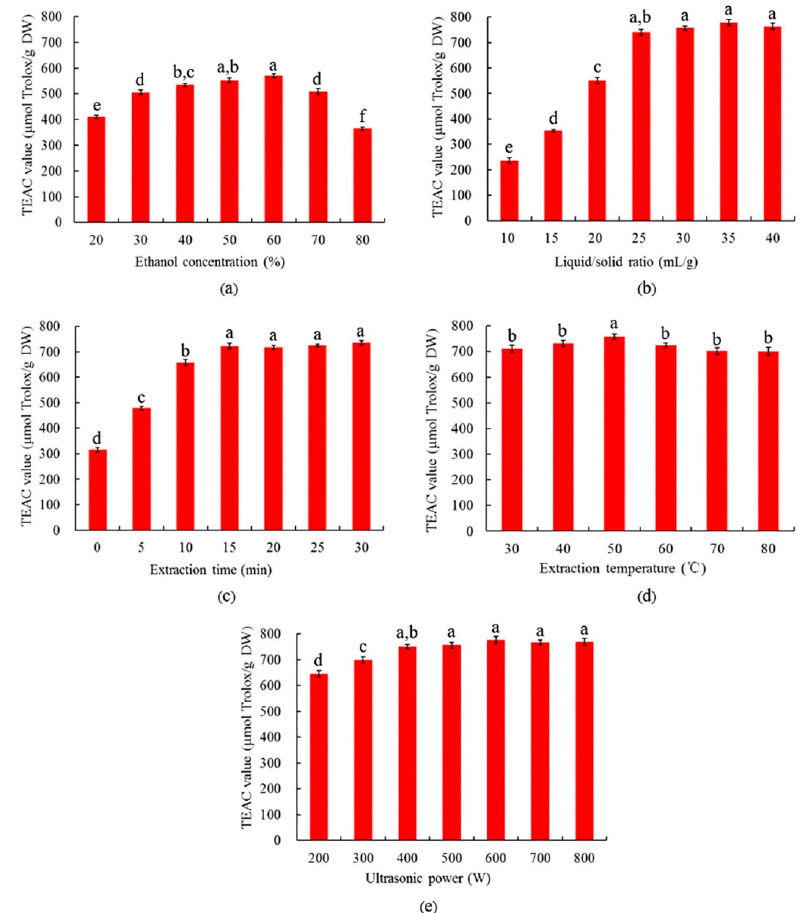
Figure 1. Effects of different extraction parameters, including ( a ) ethanol concentration, ( b ) liquid / solid (LS) ratio, ( c ) extraction time, ( d ) extraction temperature, and ( e ) ultrasound power, on Trolox equivalent antioxidant capacity (TEAC) values. Different lowercase letters indicate statistical significance at p <